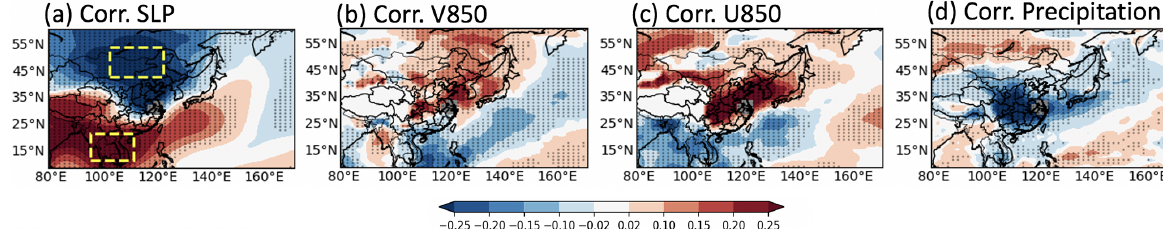
Figure 5. Correlation coefficients of daily PM 2 . 5 concentrations in YRD with (a) SLP, (b) V850, (c) U850, and (d) precipitation from nudged UKESM1 during DJF 1999–2018. Dotted regions indicate significant correlations at the 95% level from a two-tailed Student’s t test. Grey shading represents the YRD region. The regions used for the definition of a circulation-based index for YRD (Eq. 1) are marked by two yellow rectangles in panel (a)